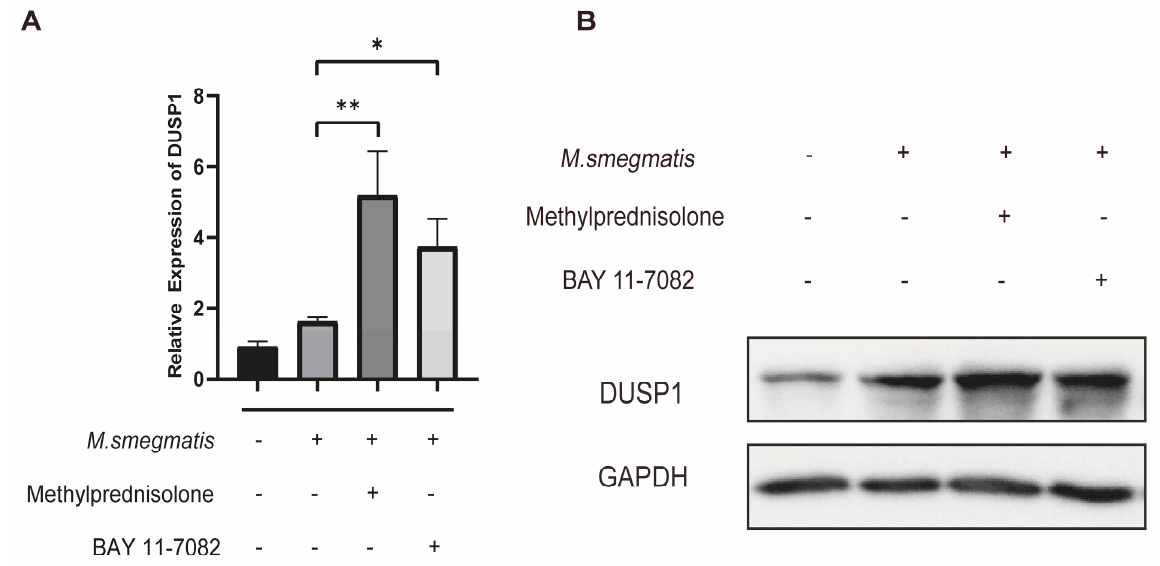
Figure 6. Methylprednisolone (10 2 µ M) treated M. smegmatis infected RAW264.7 cells for 48 h, cellular Total-RNA was verified by qRT-PCR, and total protein was extracted for Western blot analysis. ( A ) Relative expression of DUSP1 was detected with qRT-PCR, and the analysis of variance was used for data analysis; * p < 0.05; ** p < 0.01. ( B ) DUSP1 levels were detected with Western blot analysis.